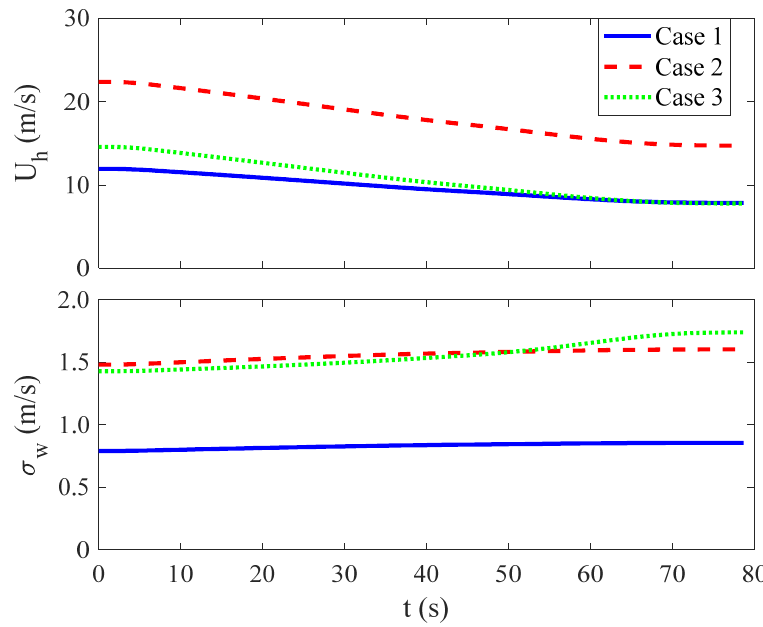
Figure 14. Time profiles of wind speed and vertical turbulence intensity.